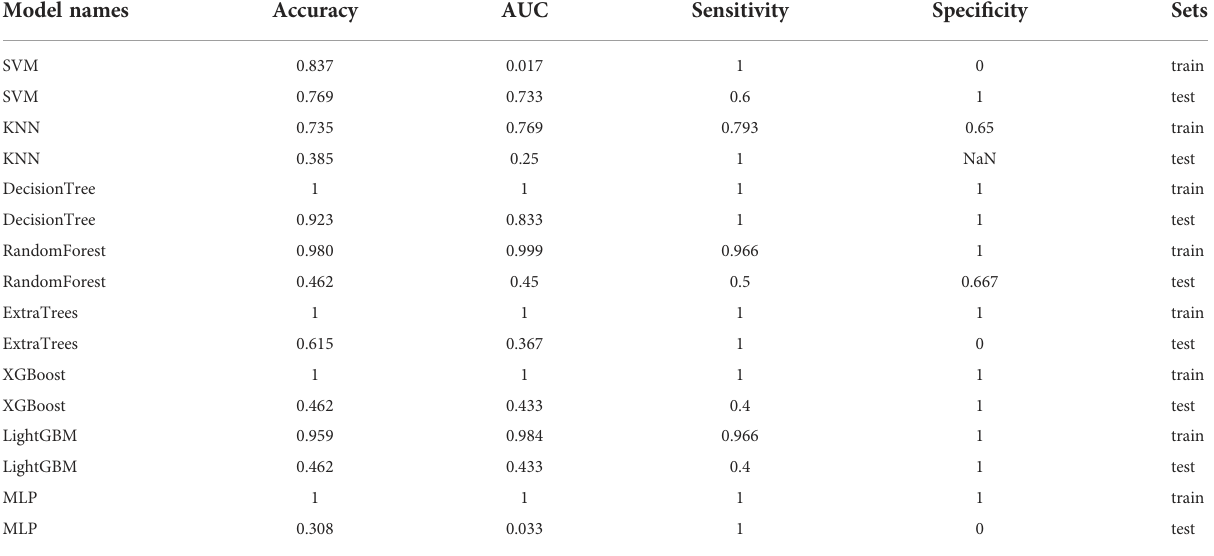
TABLE 14 Each evaluation index of the best performance of 100 random groupings in eight machine learning algorithms. Model names